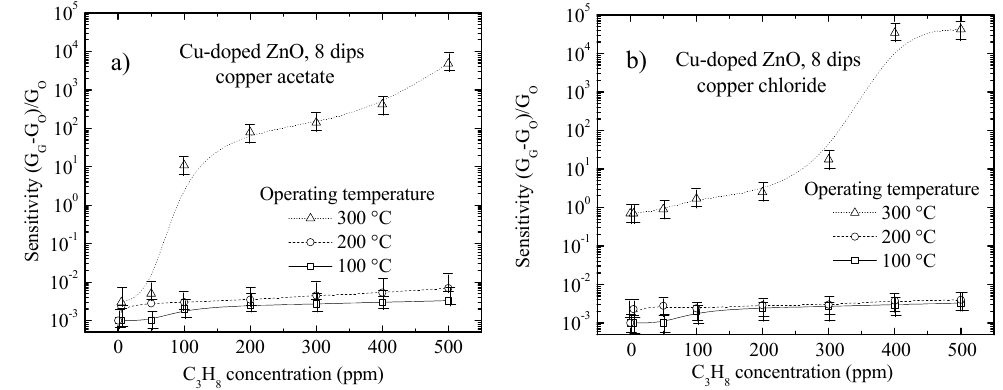
Figure 5. Variation of the sensitivity with the concentrations of propane gas at different operating temperatures for Cu-doped ZnO films prepared from eight immersions in ( a ) copper acetate and ( b ) copper chloride.